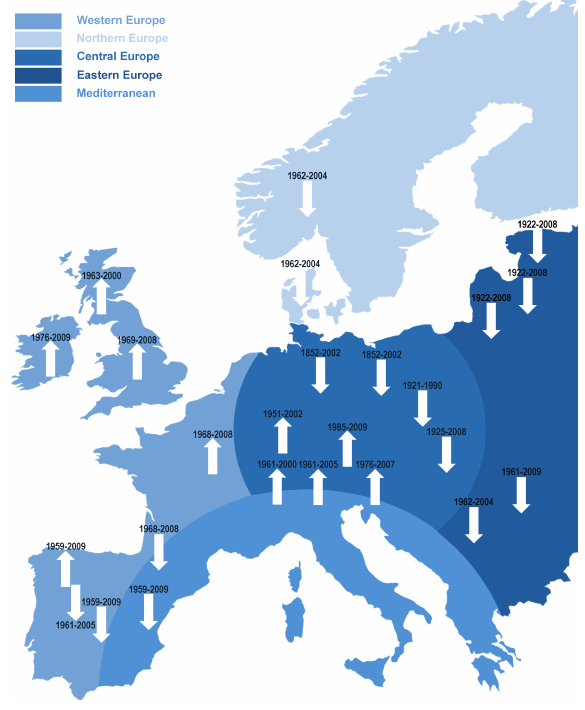
Figure 4. Schematic summarising the observed flood changes in Europe derived from cited studies using different not directly com- parable change analysis methods and time periods. Note: arrows in the schematic indicate the majority of trends including regions with weak and/or mixed change patterns. Areas with no/inconclusive studies due to insufficient data (e.g. Italy) and inconclusive change signal (e.g. Sweden) are not